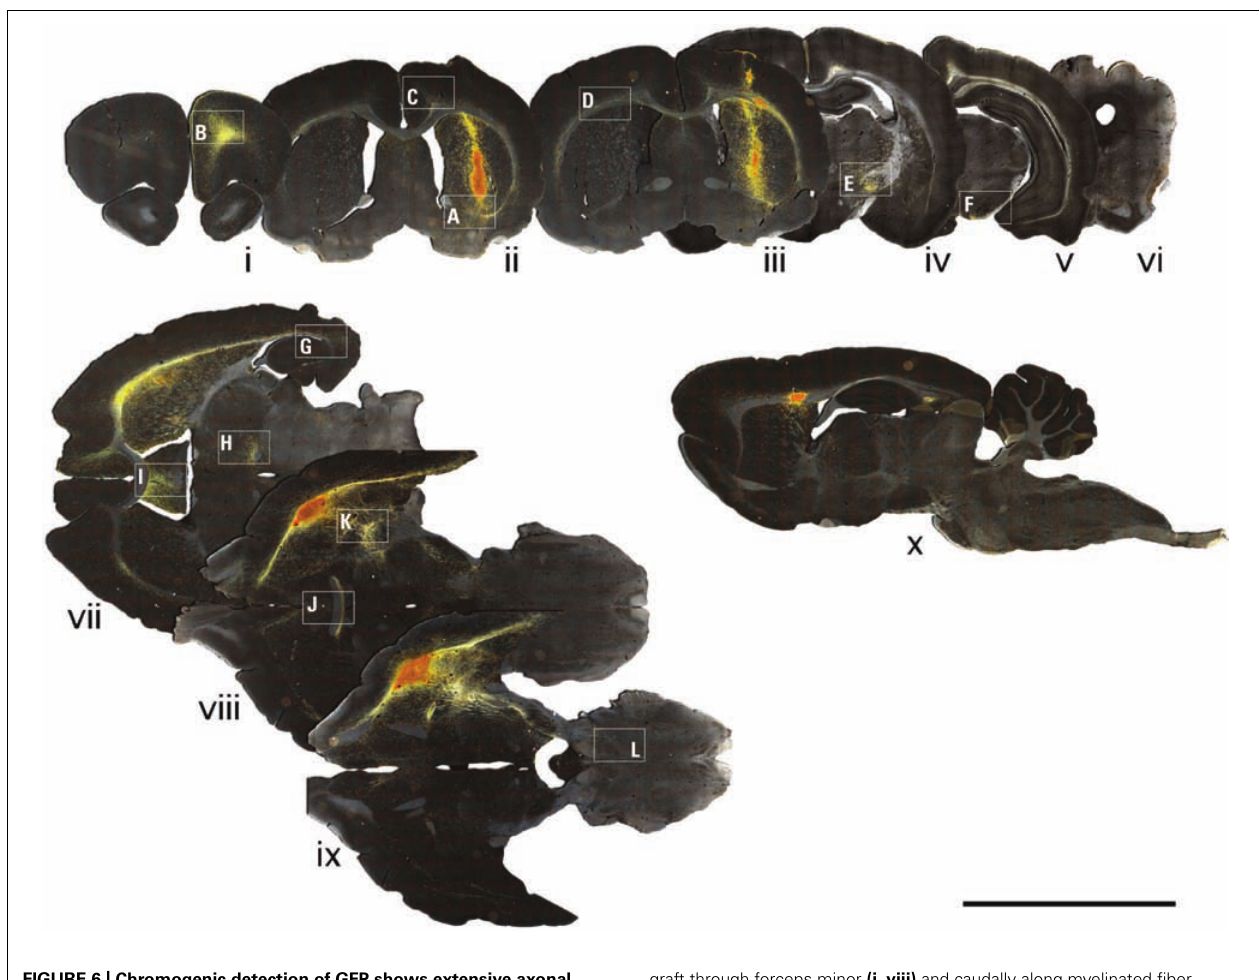
graft through forceps minor (i, viii) and caudally along myelinated fiber bundles of the internal capsule (viii, ix, x) ; as well as extensive growth in the medio-lateral plane across both hemispheres via the corpus callosum (ii, iii) and anterior commissure (vi) .The boxed areas are shown at higher magnification in Figure 7 . Scale bar: 10 mm. A high resolution version of this figure can be found online at: